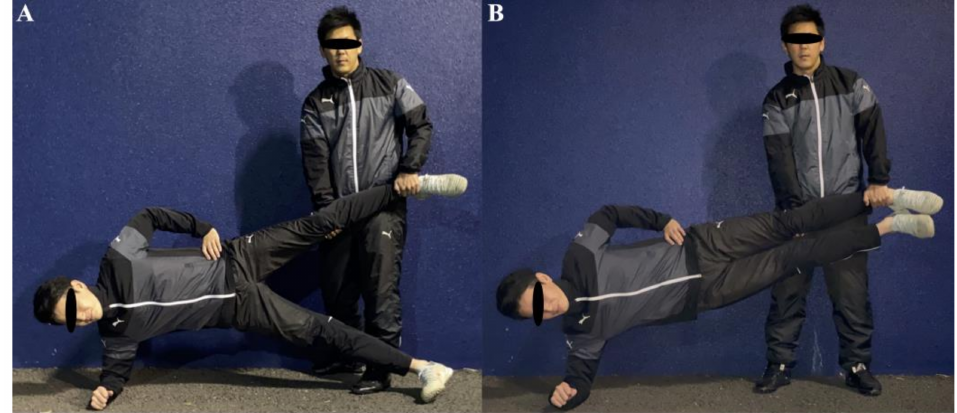
Figure 1. The Copenhagen adduction exercise. ( A ) Starting/ending position, ( B ) The mid position of the adductor muscle strengthening program.